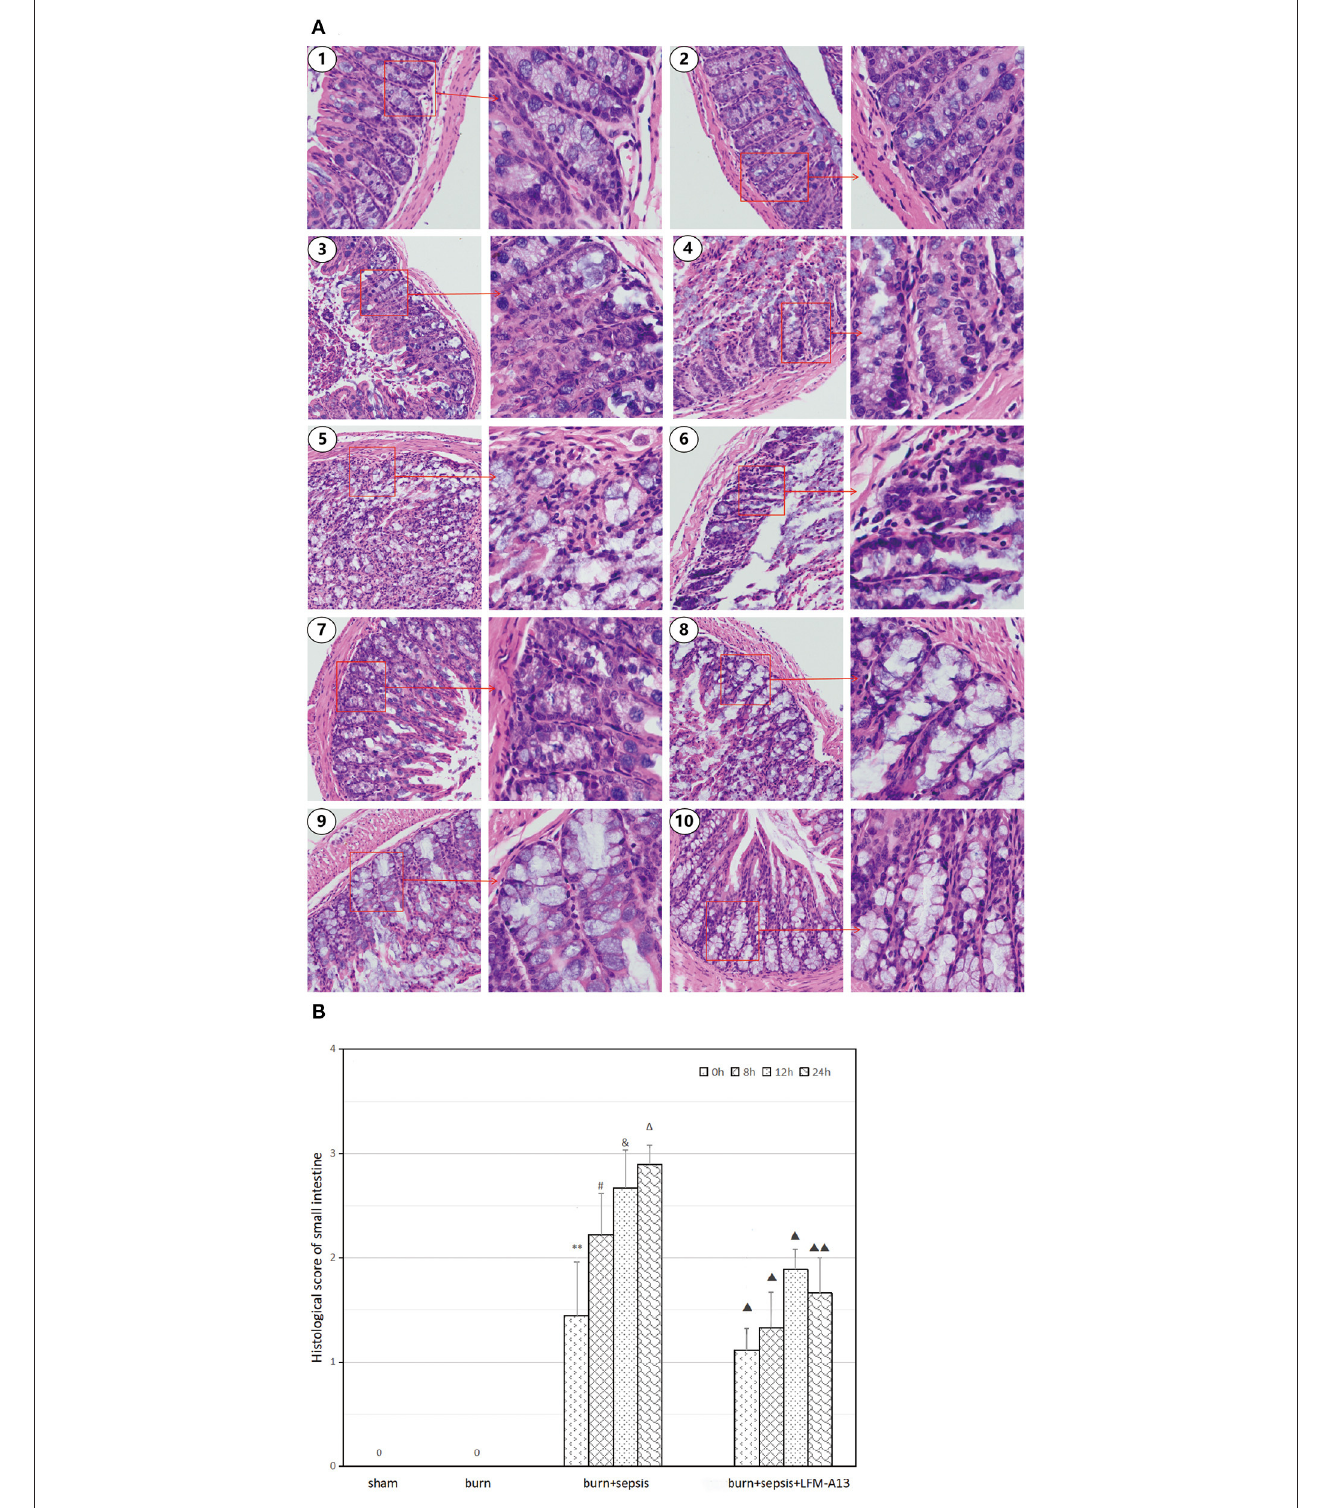
FIGURE 2 | Histopathological analysis and scores of intestinal tissue. (A) Histopathological changes in each group. (1) The sham group ( × 100 and × 400), (2) the burn group ( × 100 and × 400), (3) the burn + sepsis group at 0h ( × 100 and × 400), (4) the burn + sepsis group at 8h ( × 100 and × 400), (5) the burn + sepsis